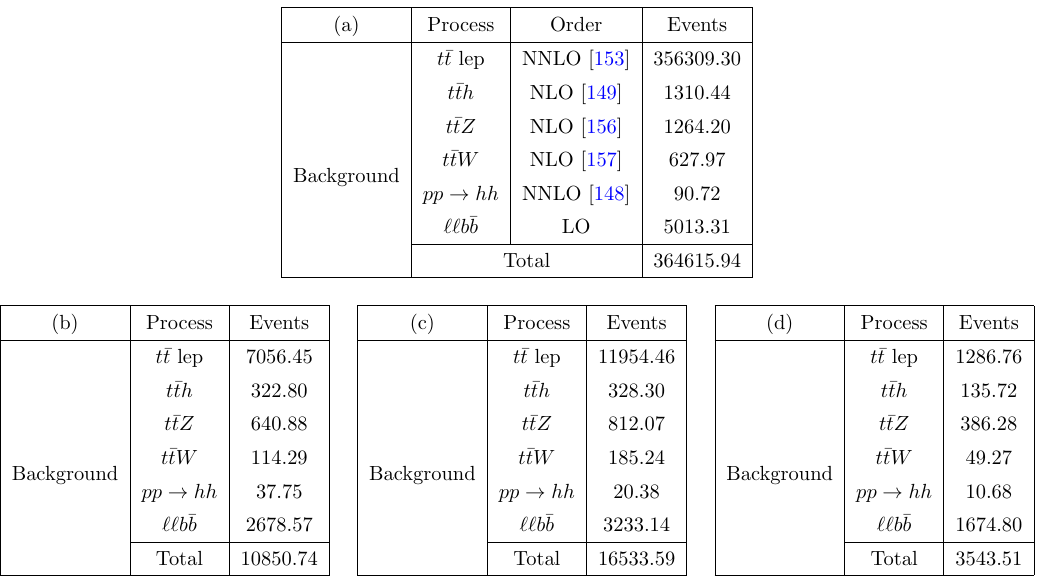
Table 11 . Respective background yields for the 2 ‘ + 2 b + =E T channel after the BDT analyses optimised for m H = ( a ) 400 GeV, ( b ) 600 GeV, ( c ) 800 GeV and ( d ) 1 TeV. The tables also list the perturbative order at which the cross-sections are considered.